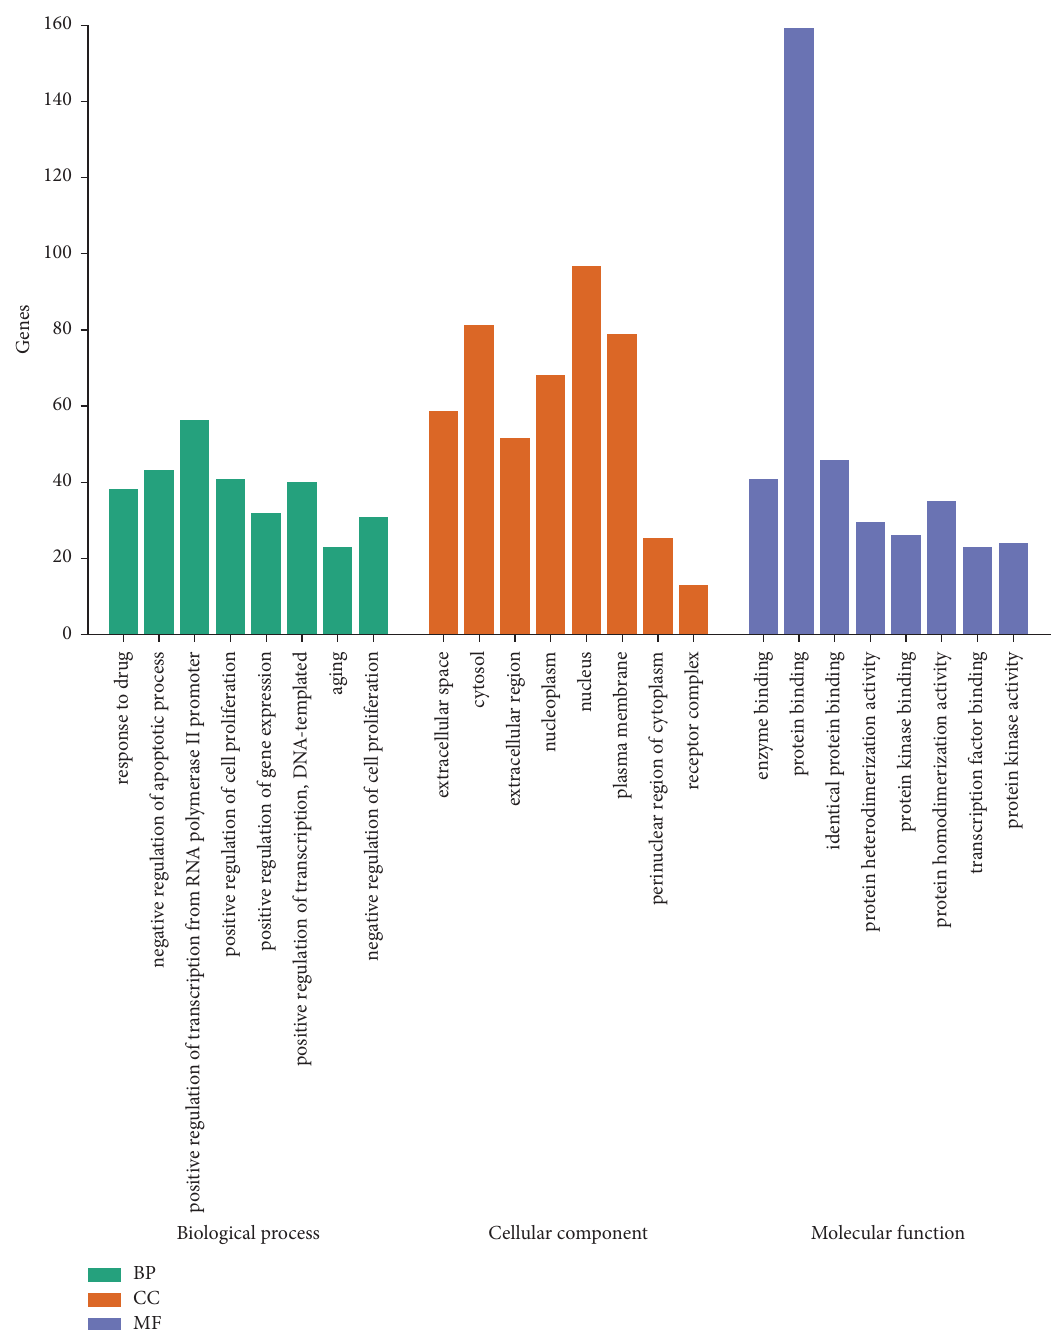
Figure 5: GO enrichment analysis of putative target genes. Te top eight functions for biological process, cellular component, and molecular function. BP, CC, and MF had direct correlation between cell cycle, cell apoptosis, and the ingredients of